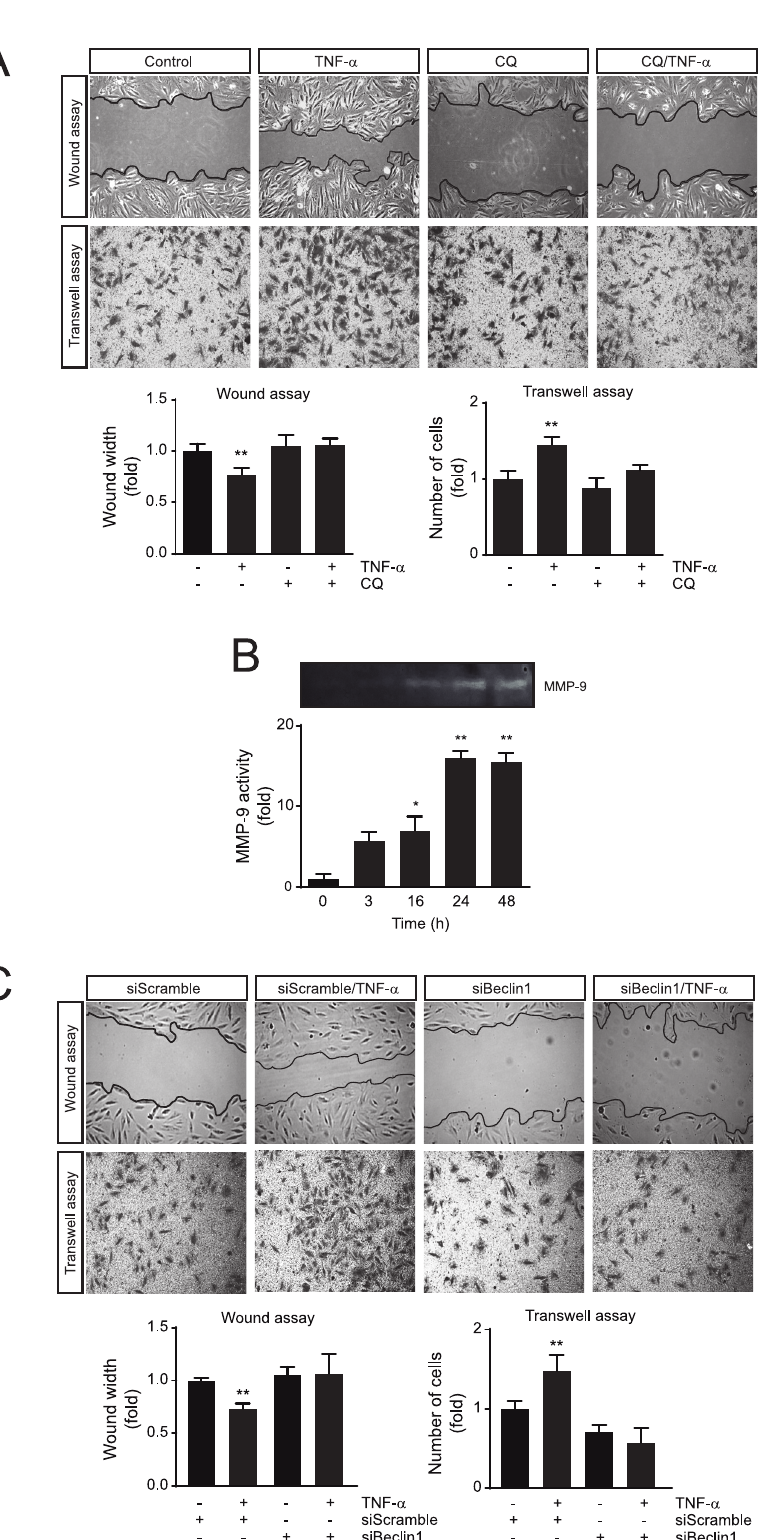
Fig 3. TNF- α requires autophagy to induce migration in A7r5 cells. ( A ) Assessment of migration by the wound healing and transwell assays in A7r5 cells stimulated with TNF- α (100 ng/mL) for 24 h in the presence or absence of chloroquine (CQ, 20 μmol/L) during the last 4 h of TNF- α stimulus (n = 4; (cid:3)(cid:3) p < 0.01 vs control) or ( C ) siScramble and